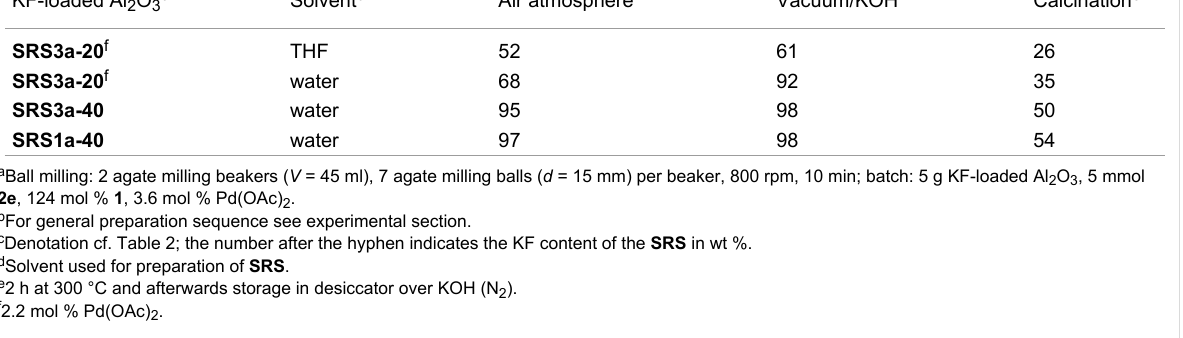
Table 3: Influence of preparation and storage conditions of KF-loaded aluminas on the yield of biphenyl ( 3e ) in the Suzuki–Miyaura reaction a of phenylboronic acid ( 1 ) with bromobenzene ( 2e ; Scheme 1). Yield of 3e (%) for preparation b /storage conditions